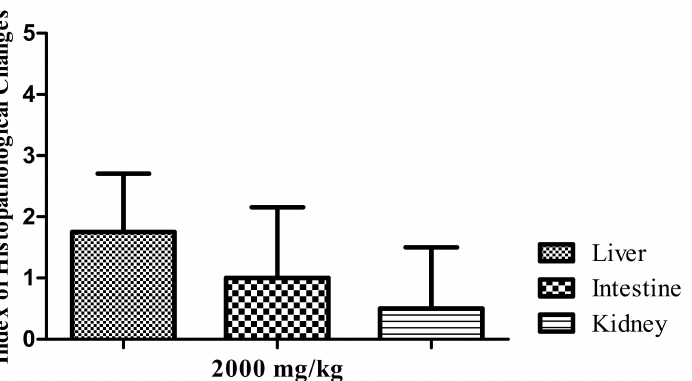
Figure 3. IHC in the liver, intestine and kidneys of adult zebrafish in the acute oral toxicity test performed using the HELTr 2000 mg/kg dose. Data show the mean ± SD ( n = 5/group). Statistical analysis was performed through one-way ANOVA followed by the post hoc Tukey